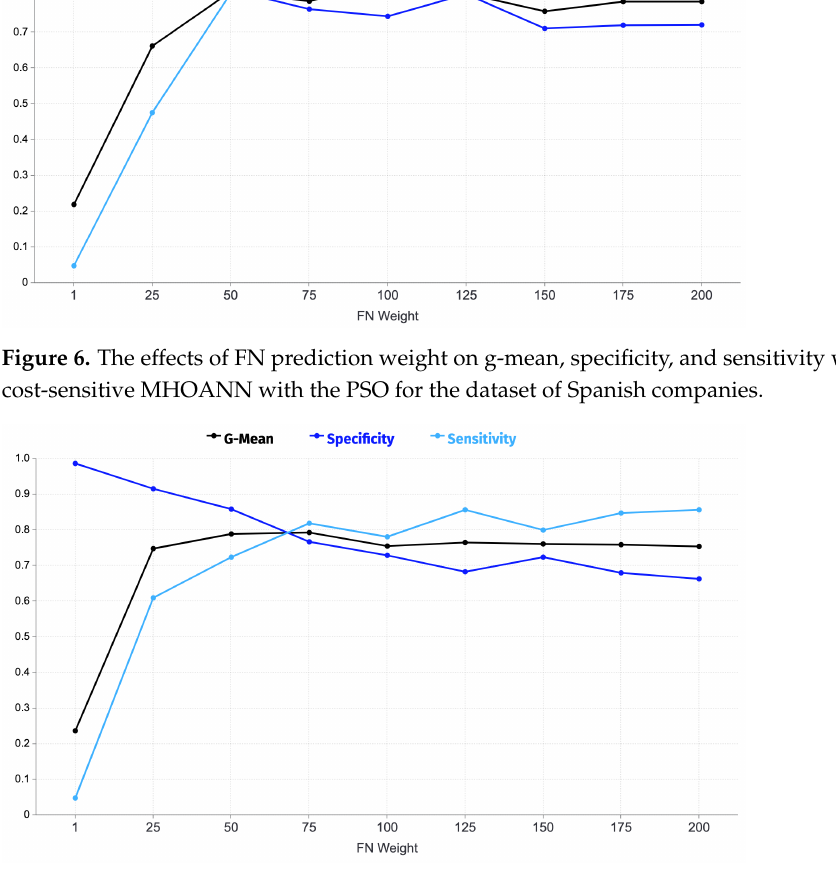
Figure 7. The effects of FN prediction weight on g-mean, specificity, and sensitivity when using the cost-sensitive MHOANN with the CSO for the dataset of Spanish companies.